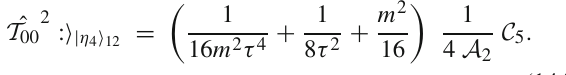
(d) The D T is plotted as a function of coherent param- | η 3 (cid:2) 12 ( o ) eter for fixed values of squeezing parameters. Here, with the D T (c) The is plotted as a function of squeezing pa- increasing values of coherent parameter the nonclassical char- | η 3 (cid:2) 12 ( o ) acter of the | η 3 (cid:2) starts decreasing and then become constant rameter for fixed values of coherent parameters. Here, with (cid:3) 1. increase in the strength of squeezing the D T at 0 . 5, where we may regard D T increases. | η 3 (cid:2) 12 ( o ) | η 3 (cid:2) 12 ( o ) Fig. 18 a is the array plot and b – d are the respectively 3-D and 2-D plots for the D T in 3rd quasi-Bell state of TMSEC states, plotted as a function of coherent parameter | (cid:11) | and squeezing parameter r .